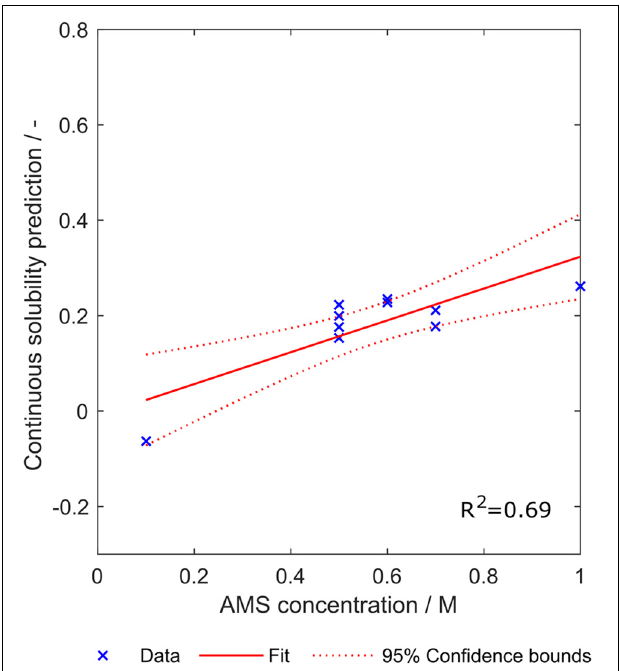
FIGURE 10 | Relationship between the continuous solubility prediction value and optimal ammonium sulfate concentration for precipitation of ten constructs. Eight scales were used, which were generated with a scale table optimization procedure (Set S 8 , 1 ). Goodness of fit is indicated by 95% confidence bounds and R 2